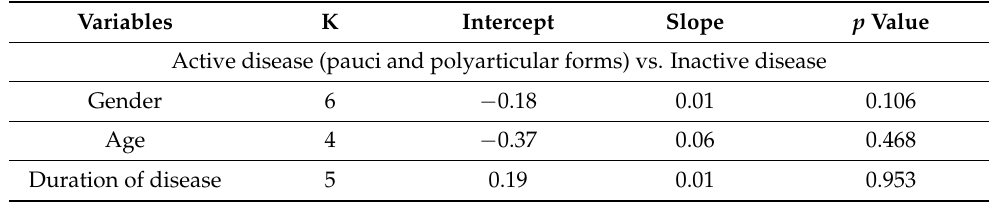
Figure 5. Calprotectin levels at 3–6 months (follow-up) between active and inactive disease: ( A ) Forest Plot of overall cases; ( B ) Funnel Plot; ( C )forest plot according baseline therapy. Table 2. Meta-regression